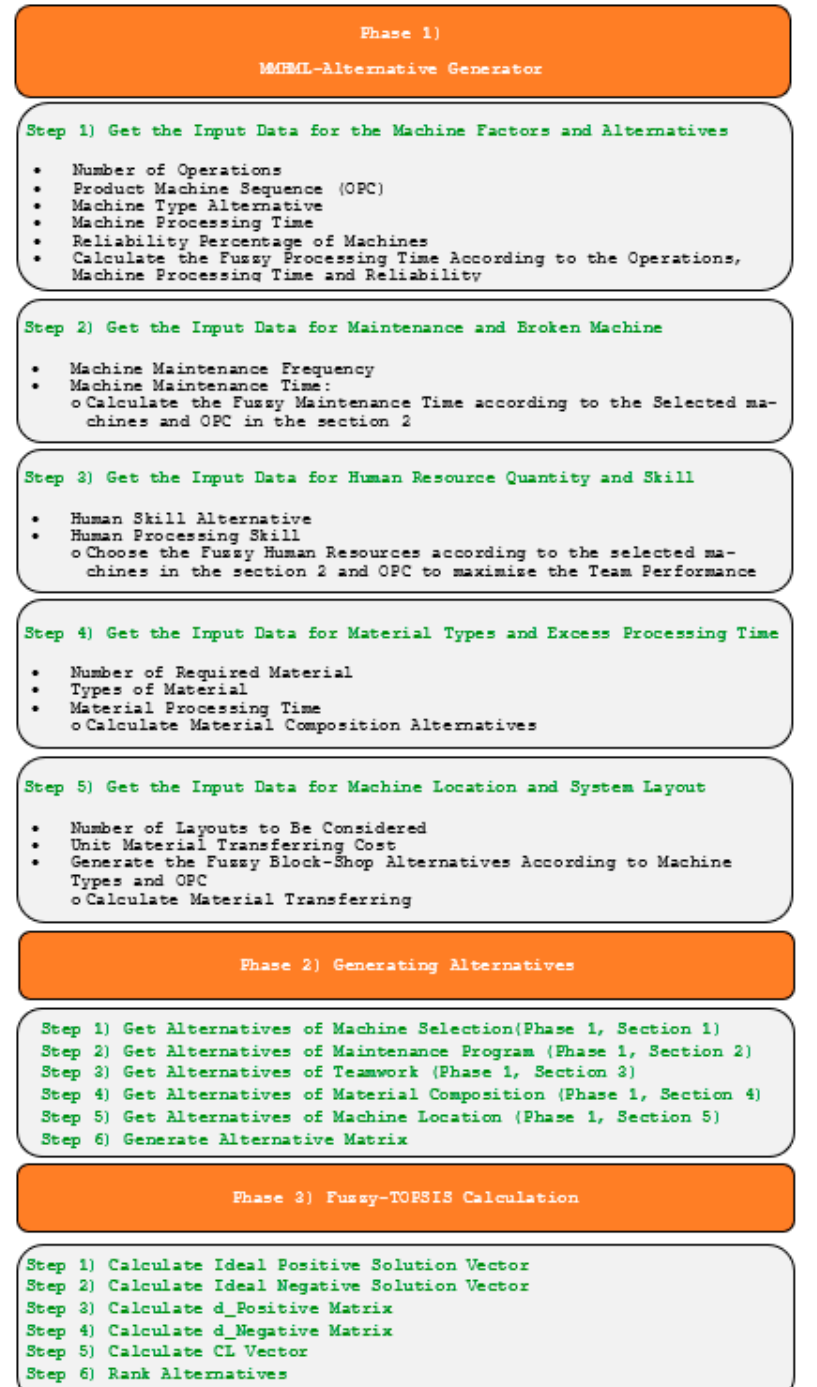
Figure 18. Flow chart of the proposed hybrid fuzzy–TOPSIS heuristic.